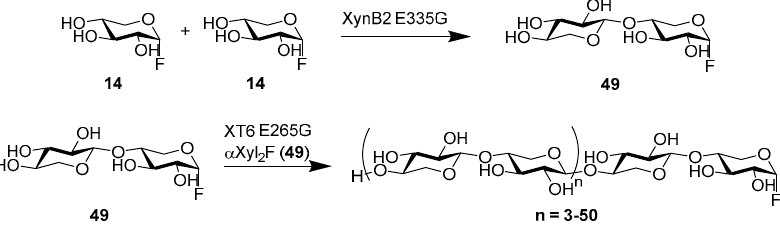
Scheme 8. Production of xylooligomers comprising 6–100 monomers by exploitation of the self- condensation of α XylF ( 14 ) and Xyl 2 F ( 49 ) catalyzed by the enzyme combination of XynB2 E335G and XT6 E265G